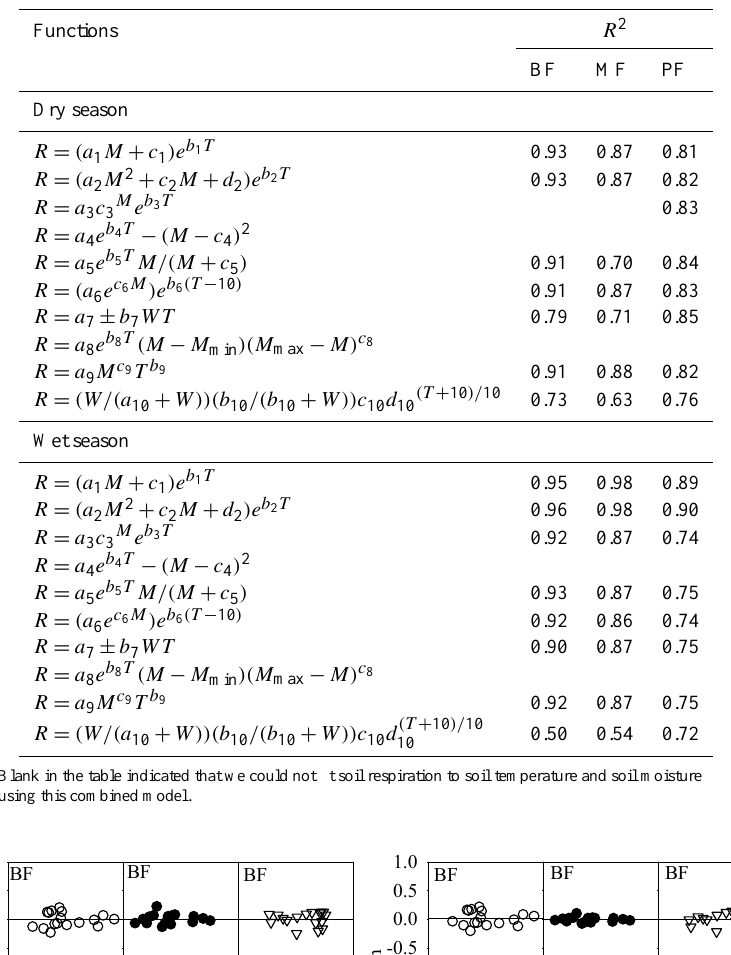
Table A4. Coefficient ( R 2 ) of measured soil respiration ( R) to soil temperature ( T ) and moisture ( M) using different combined models at the DNR forests with control plots.